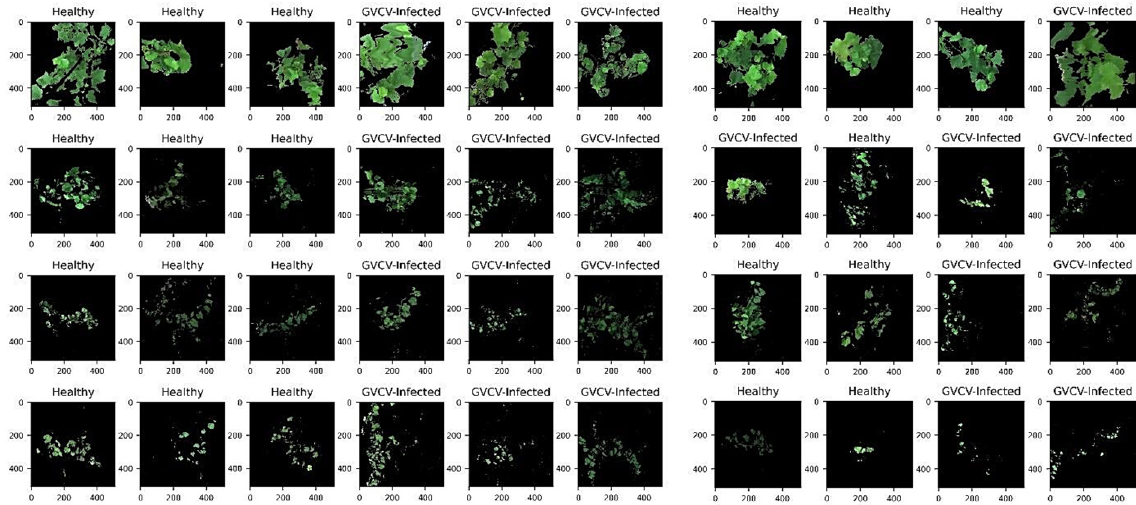
Figure 3. Pseudo red-green-blue (RGB) hyperspectral images in the training set ( n = 24 images) and testing set ( n = 16 images). The image dimensions are 512 × 512 pixels × 203 spectral bands. The row order corresponds to the measuring dates (August 7th, August 29th, September 19th, and October 8th). Training images (3 healthy and 3 GVCV vines) were randomly selected from each measure. Image backgrounds (soil, grass, sky, etc.) were masked out and only grapevines pixels were retained after the segmentation task. The August 7th images (first row) were acquired at a vertical (nadiral) angle. Subsequent images were acquired at a horizontal (lateral)